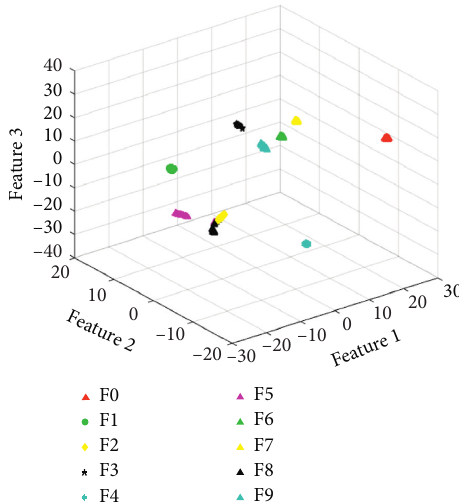
Figure 7: Visualization of features extracted by the 1D-WDRSN